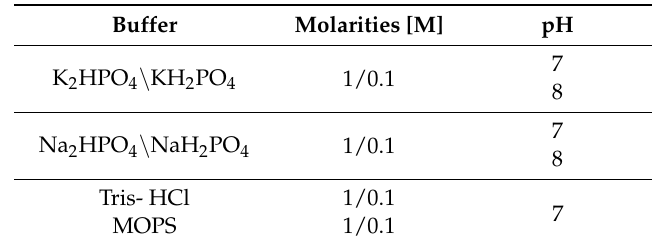
Table 2. Different buffers for immobilization reactions of CaLB on Accurel beads. All buffers had concentrations of 1 and 0.1 M. Tris-HCl and MOPS were used at pH 7, while K 2 HPO 4 \ KH 2 PO 4 and Na 2 HPO 4 \ NaH 2 PO 4 were used at pH 7 and 8